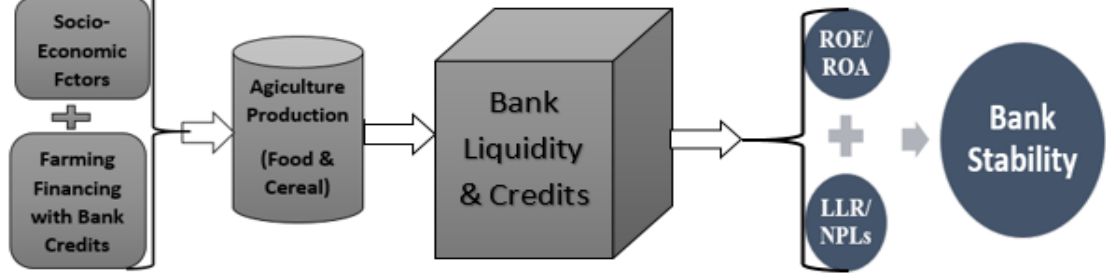
Figure 4: Illustrates The Framework of Our Thinking on The Crucial Mediating Role of The Agro-Production on Bank Risk and Profit, Attribute of Bank Stability; Source: Own